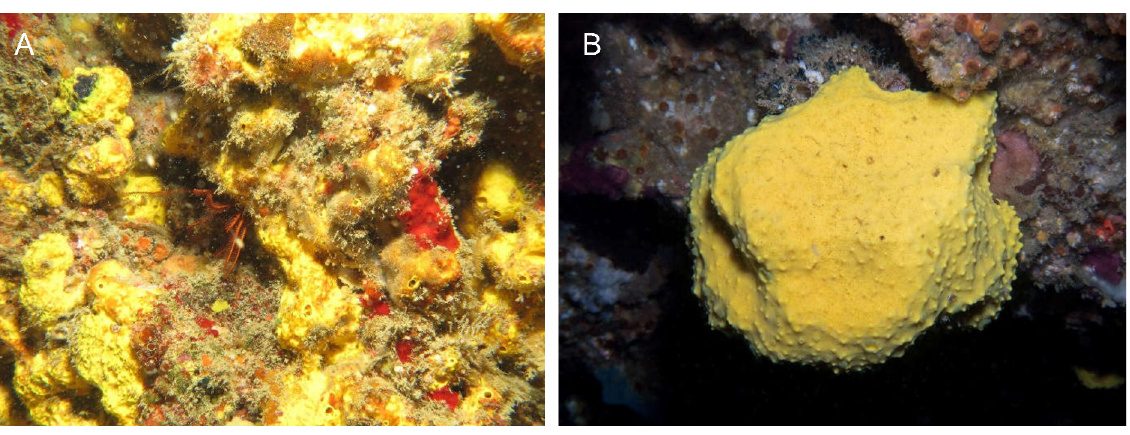
Fig. 3. Pseudoceratina purpurea (Carter, 1880). A . Encrusting specimen in situ (PO4). B . Massive specimen in situ